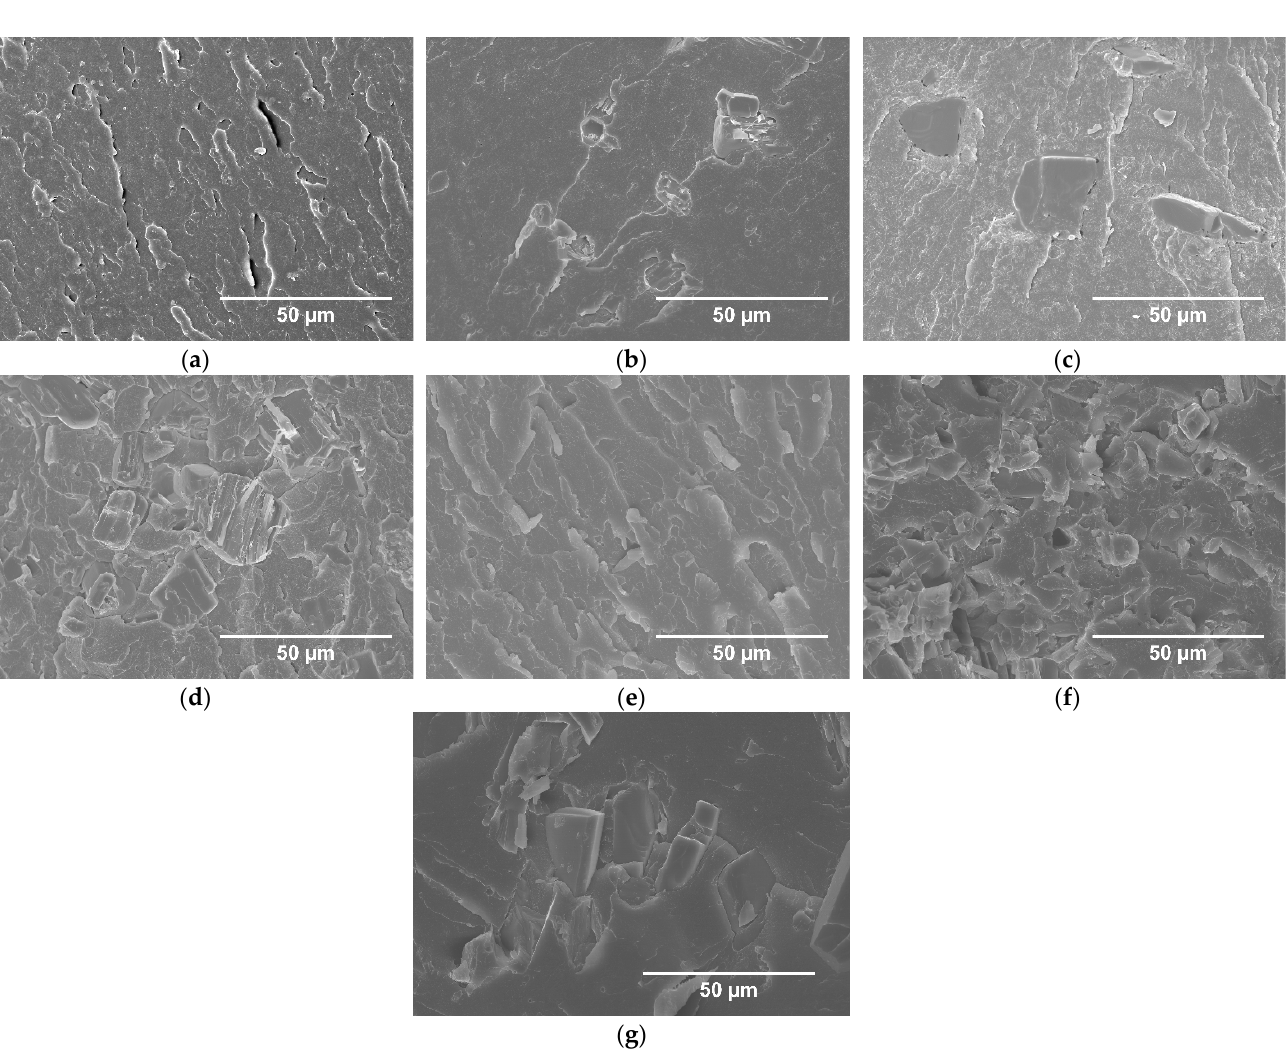
Figure 2. SEM images of breakthroughs of UP ( a ), UP/10 ammonium polyphosphate (APP) ( b ), UP/20APP ( c ), UP/30APP ( d ), UP/10LHP ( e ), UP/20LHP ( f ), UP/30LHP ( g ).